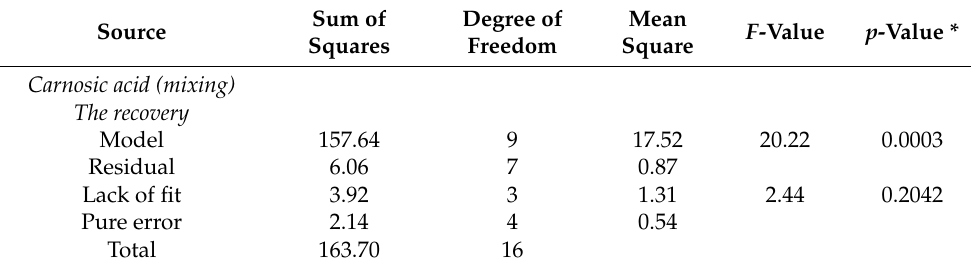
Table A3. Analysis of variance (ANOVA) of the modelled responses for carnosic